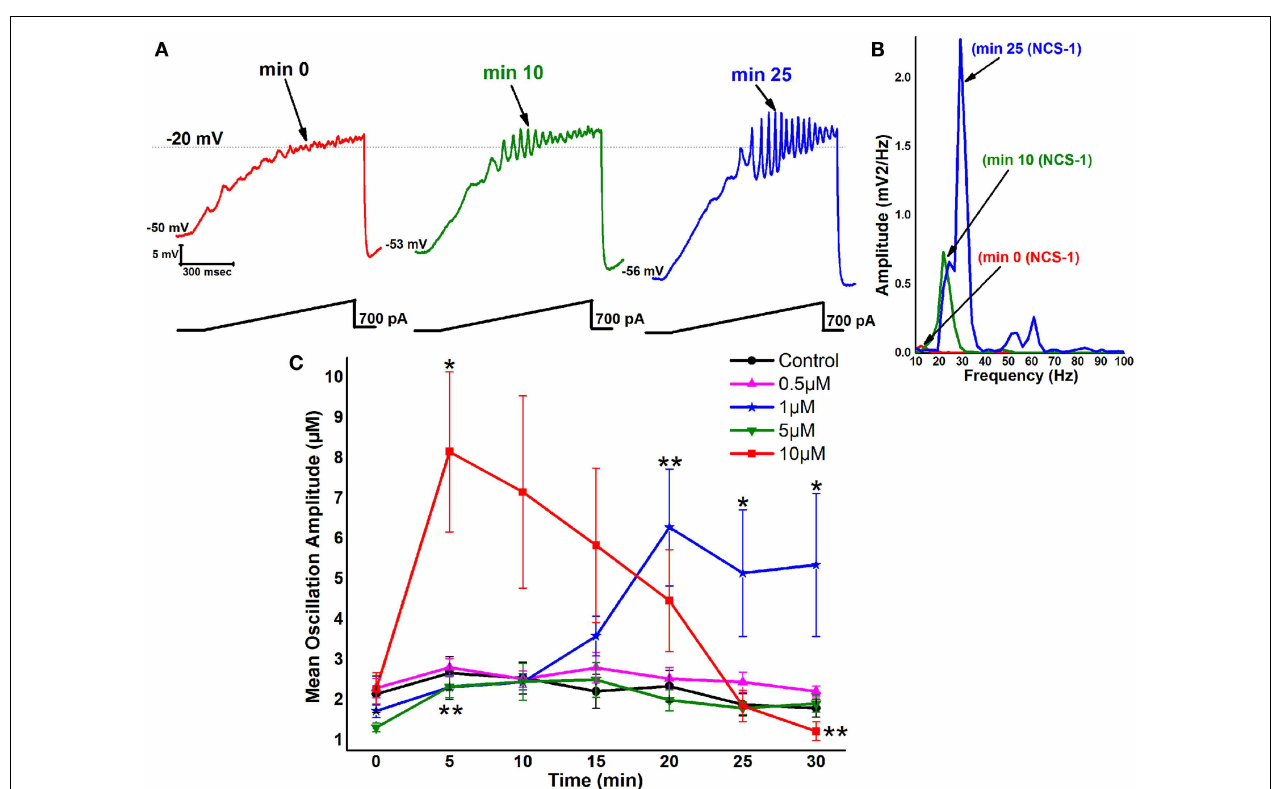
time. Cells recorded using 0.5 µ M NCS-1 also showed no significant changes over time (pink triangles). Cells recorded using 1 µ M NCS-1 (blue stars) showed significant increases in mean peak oscillation amplitude at 20–30min. Cells recoded using 5 µ M NCS-1 (green downward triangles) showed no significant changes over time, but cells recorded using 10 µ M NCS-1 (red squares) showed a significant increase in mean peak oscillation amplitude at 10min, but not thereafter. * p < 0.05; ** p < 0.01.These results suggest that NCS-1 at low concentrations potentiates beta/gamma oscillations in PPN neurons, but at high concentrations compatible with over expression it reduces or blocks high-frequency membrane oscillations (64,